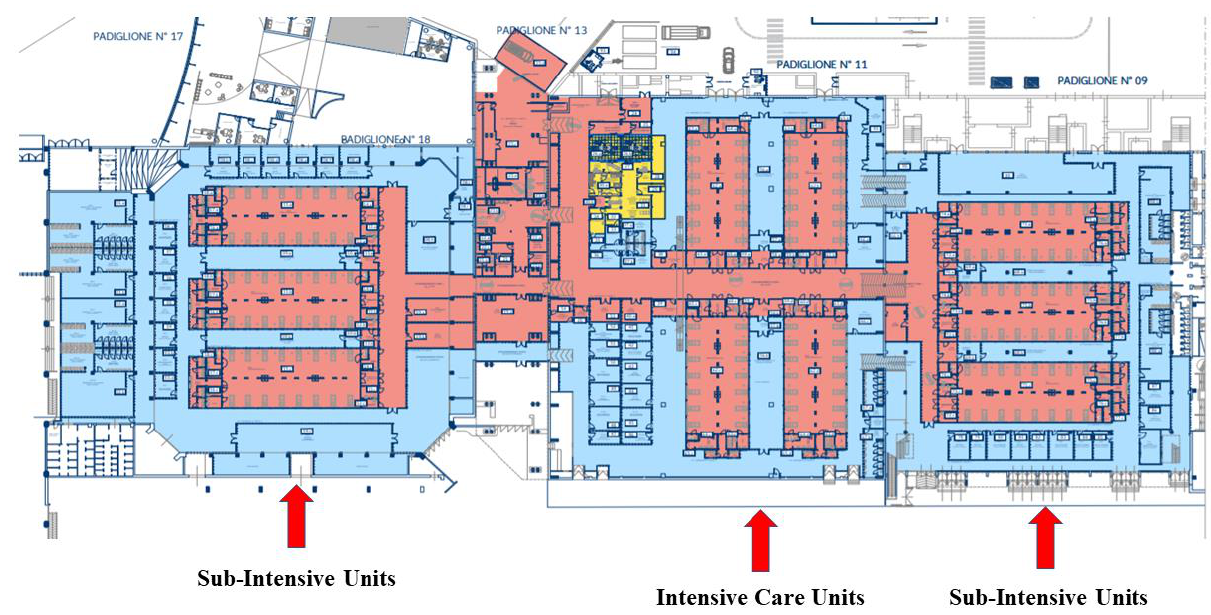
Figure 1. Planimetry of “Presidio Maxi-Emergenze” COVID-19 Hospital.